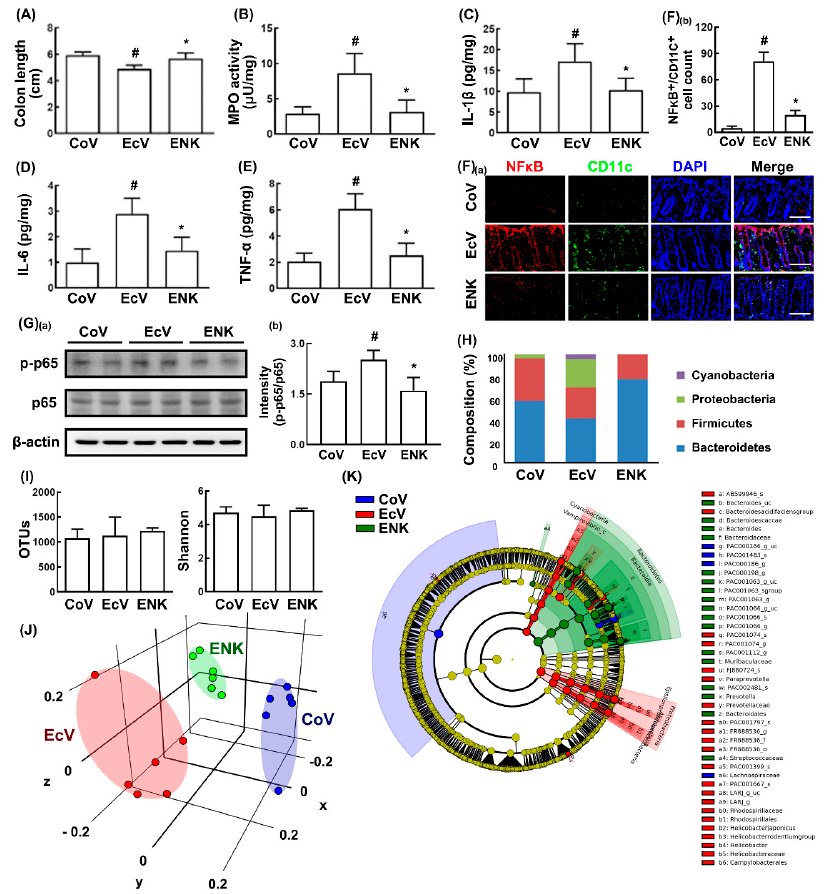
Figure 4. NK109 alleviated K1-induced colitis and gut microbiota alteration in the mice. E ff ects on the colon length ( A ), myeloperoxidase (MPO) activity ( B ), IL-1 β ( C ), IL-6 ( D ), and TNF- α ( E ) expression. ( F ) E ff ect on the colon NF- κ B + / CD11c + cell population ( a ) and its intensity ( b ). ( G ) E ff ect on the NF- κ B activation ( a ) and its intensity ( b ). E ff ects on the composition of gut microbiota: Phylum ( H ), operational taxonomic units (OTUs) and Shannon ( I ), PCoA plot based on based on Jansen–Shannon ( J ), and Cladogram generated by LEfSE showing significant di ff erences in the abundance of gut microbial composition among the CoV (blue), EcV (red), and ENK (green) groups ( K ). The EcV and ENK groups were exposed to K1 (1 × 10 9 CFUs / mouse / day) and thereafter treated with NK109 (for ENK, 1 × 10 9 CFUs / mouse / day) or the vehicle (for EcV) for 5 days. The control group (CoV) was treated with the vehicle instead of K1 and NK109. Data values are described as mean ± SD ( n = 6). # p < 0.05 vs. CoV. * p < 0.05 vs.